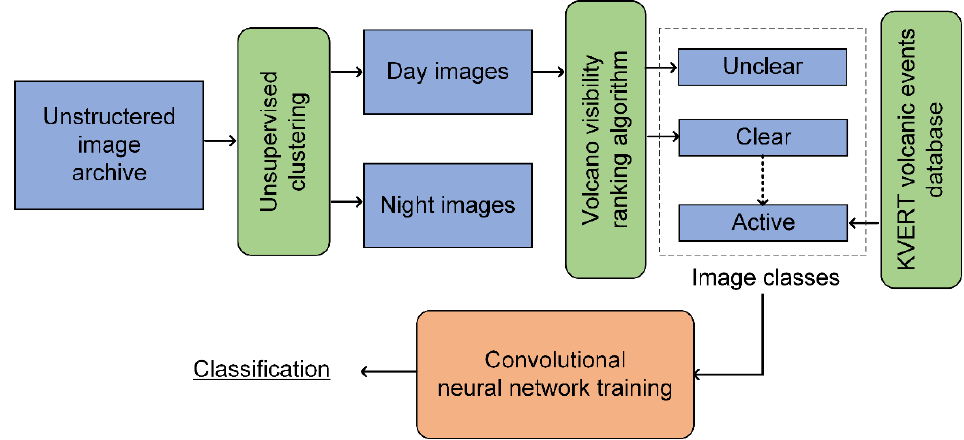
Figure 3. The flowchart diagram of the proposed algorithm to produce labelled dataset for CNN classification training.